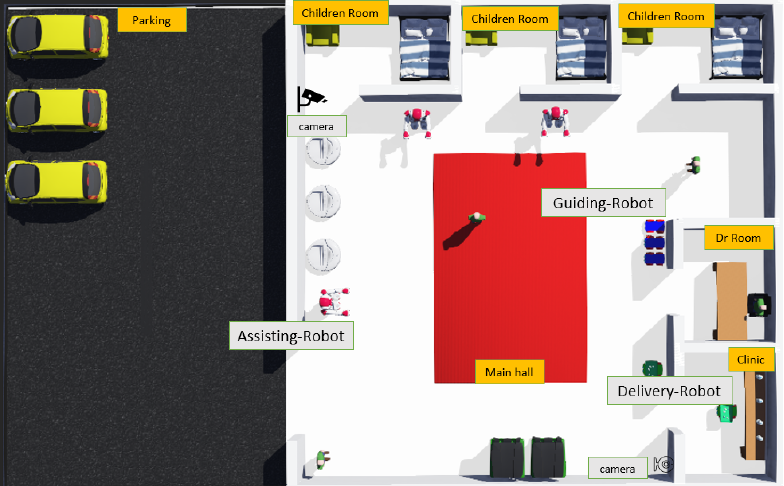
Figure 6. Children Hospital Domain showing an IoT collective consisting of multiple robots, smart cameras with patients and Dr.